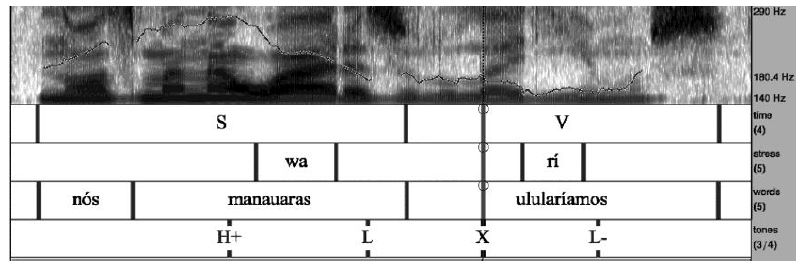
Figure 8. F0-track from recording with narrow focus on the